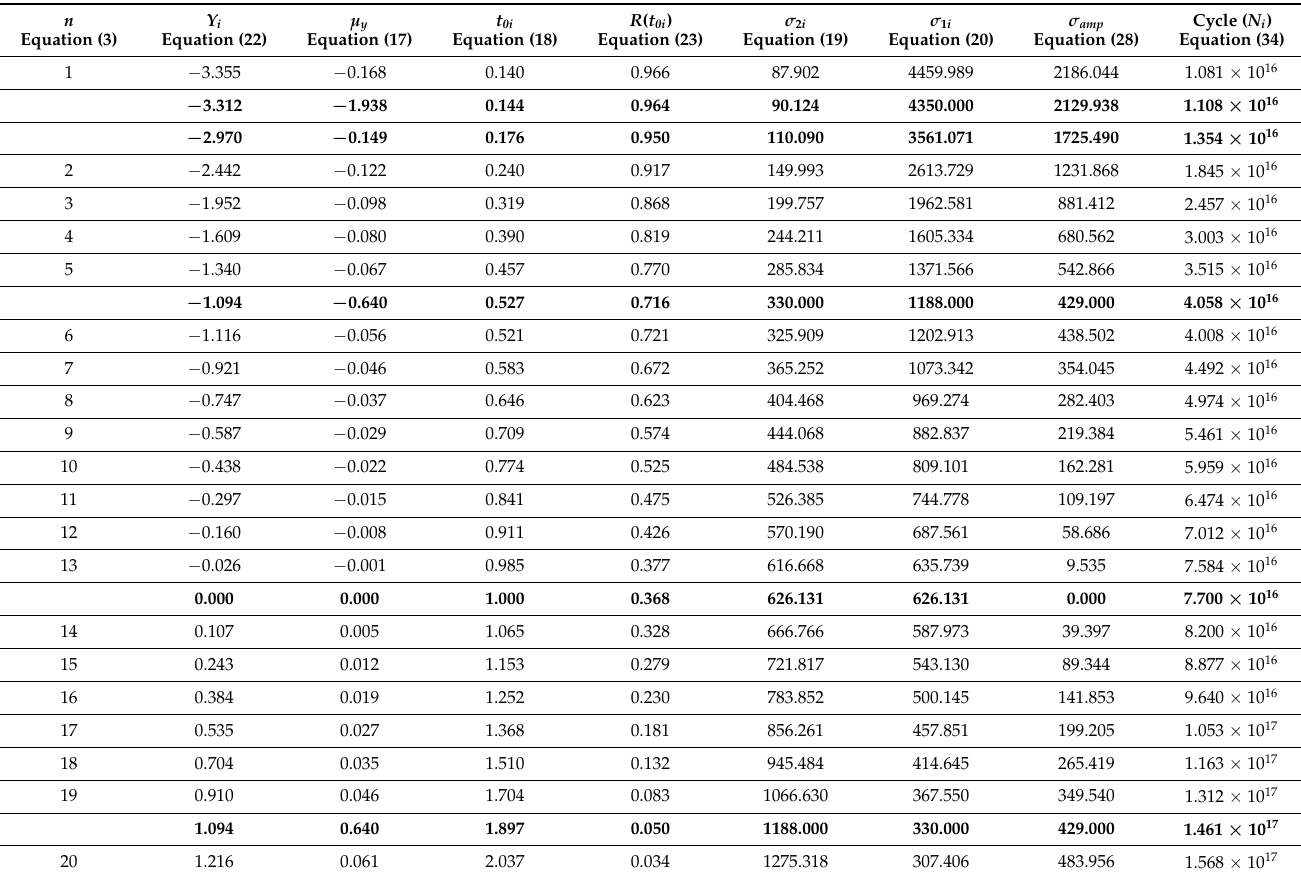
Table 5. Weibull statistics for cycle to failure analysis.